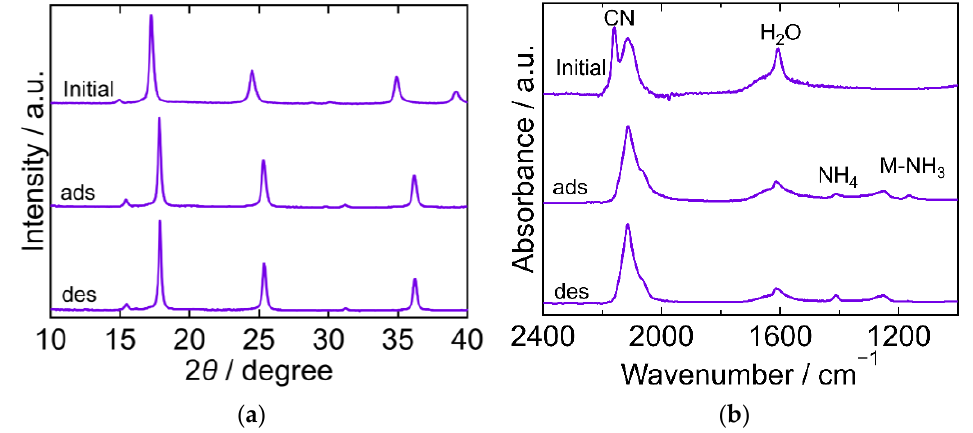
Figure 6. XRD patterns ( a ) and FTIR spectra ( b ) of cobalt hexacyanoferrate (CoHCF). “Initial” sample is literally the sample before adsorption. The samples after adsorption and desorption are denoted by “ads” and “des”, respectively. The measurements were performed at ambient temperature.